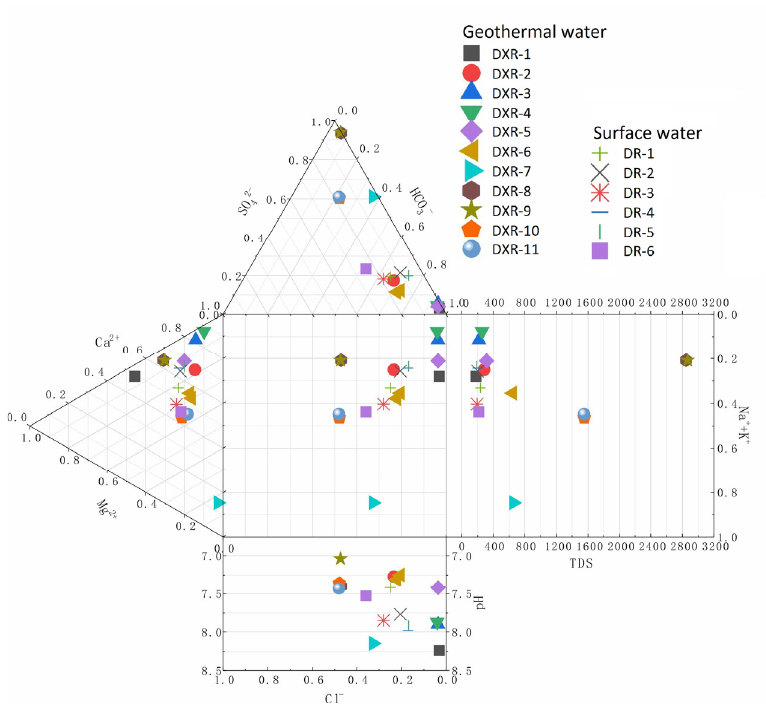
Figure 2. Durov plot of water sample in the study area.